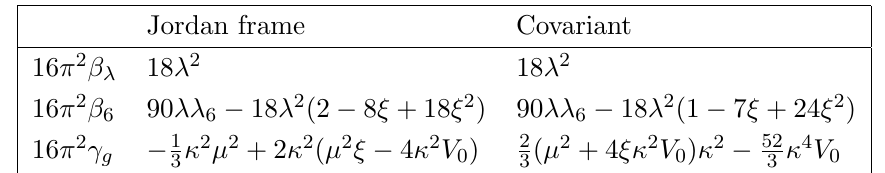
Table 2 . (cid:12) (cid:0) functions for the quartic scalar self-coupling (cid:21) and the sixth order scalar self-coupling (cid:21) 6 of a gravity coupled scalar (cid:12)eld at leading order for small (cid:20) 4 V 0 . The wave function renormalisa- tion of the metric (cid:13) g is given at order (cid:20) 4 V 0 . The Jordan frame results have been calculated directly from the original action. The Einstein frame results are obtained by transforming the action to the Einstein frame. The covariant result uses a geodesic expansion on (cid:12)eld space and is independent of the frame